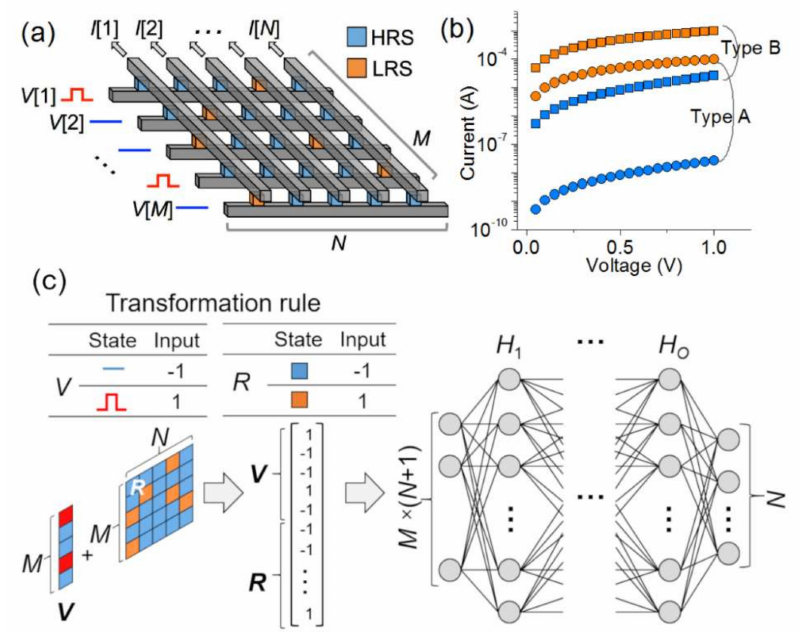
Figure 1. ( a ) Schematic of an M × N crossbar array. ( b ) Assumed I - V characteristics of the model resistance-switches (Types A and B). ( c ) Schematic of the MLP with M × ( N + 1) input and N output units, and O hidden layers. The rule for mapping resistance-switches and input voltage arrays to an input vector is tabulated in the